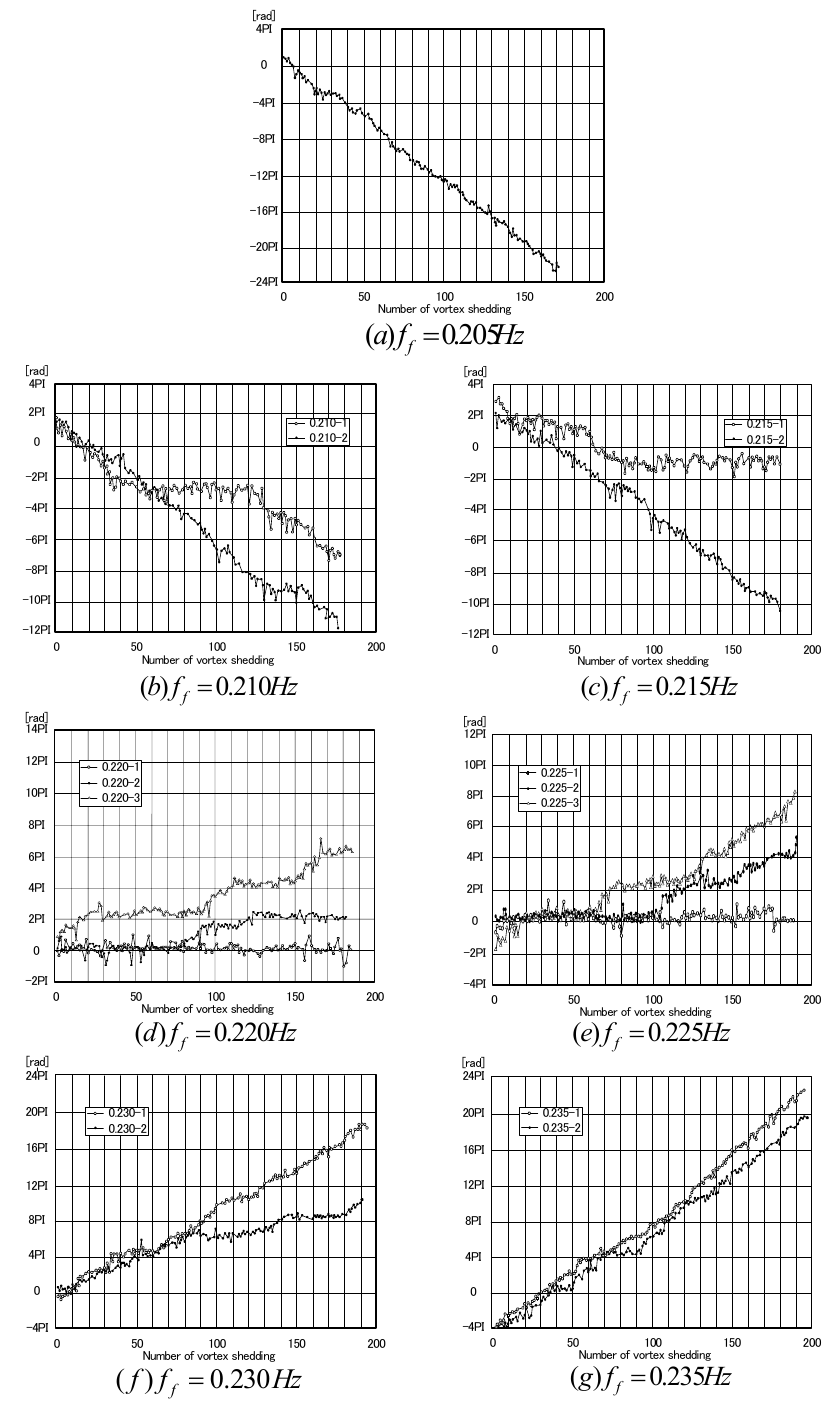
Fig.7 Phase lag variation with time at each forced oscillation frequency of the test